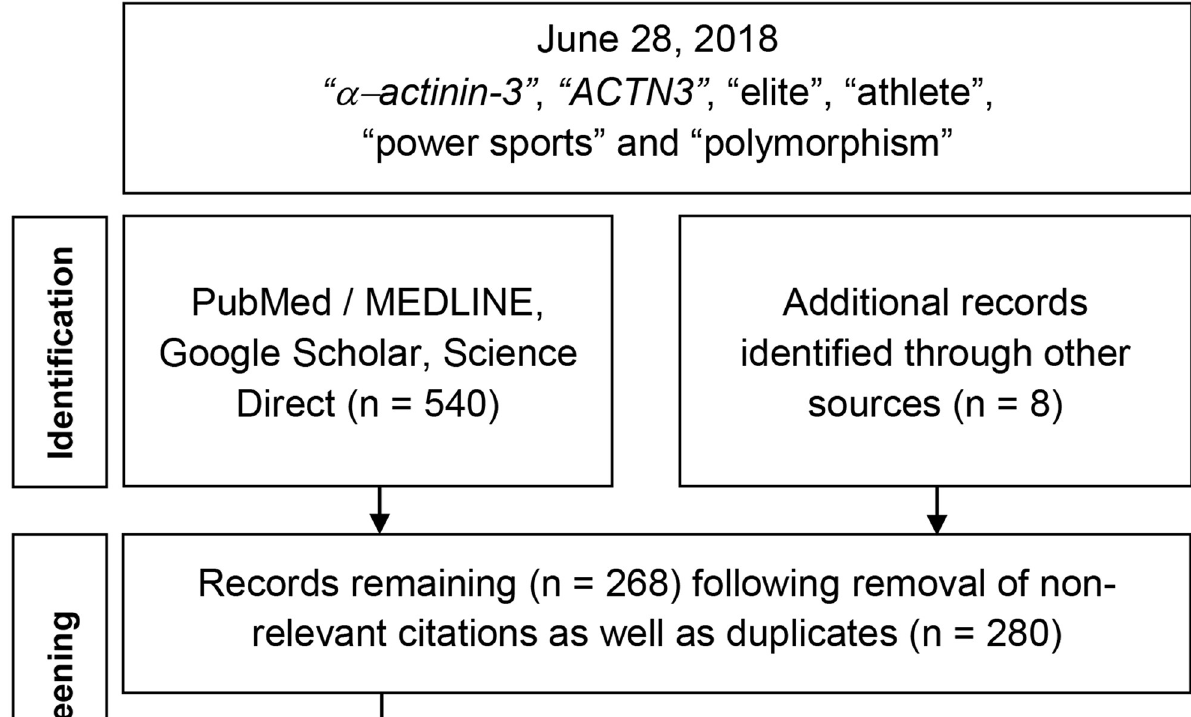
PLOS ONE | https://doi.org/10.1371/journal.pone.0217390 May 30,